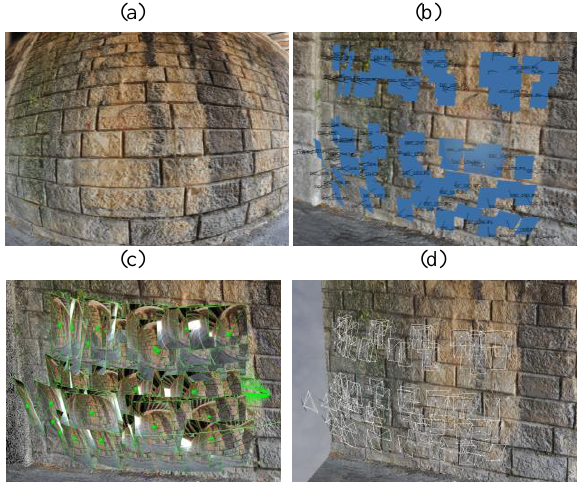
Figure 1. (a) An image of the block used for camera calibration and camera poses in the calibration project with PhotoScan (b), Pix4D (c) and ContextCapture (d).